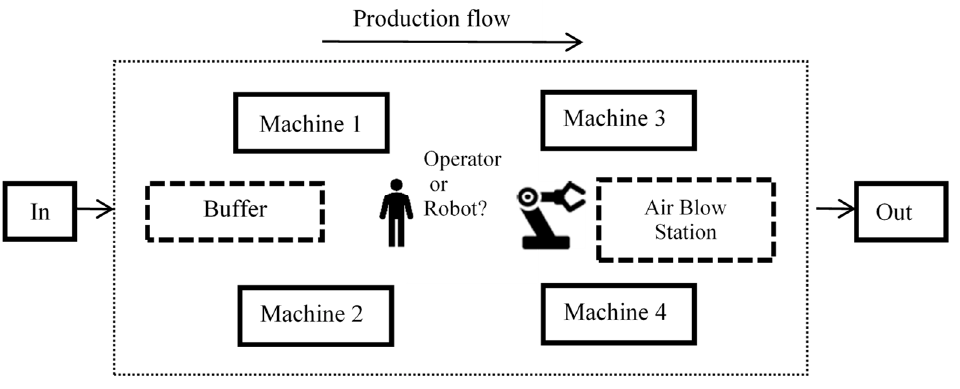
Figure 3 . The schema of the main machining cell.